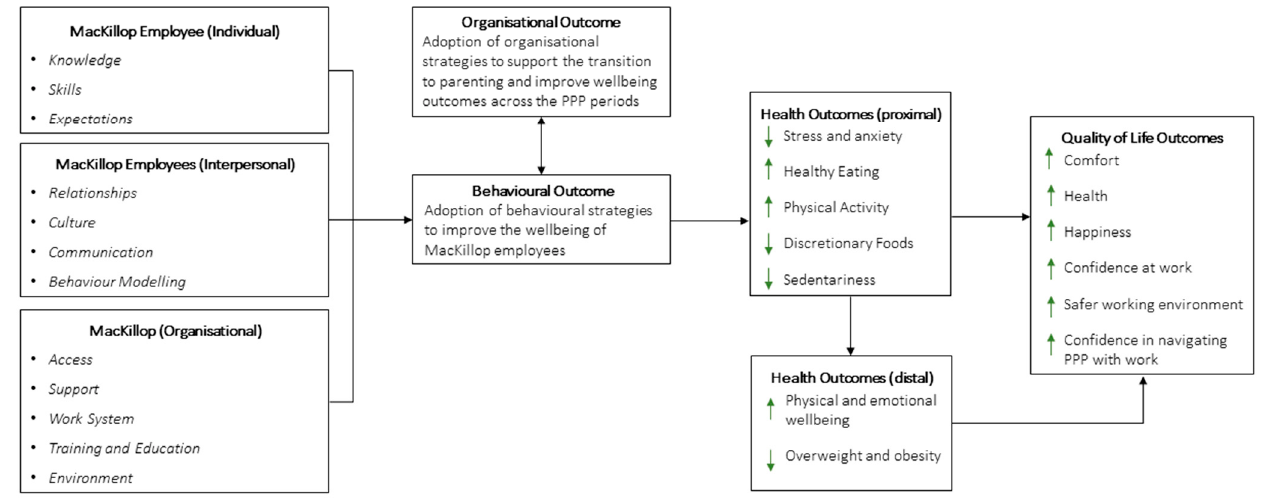
Figure 1. Logic Model of the HiPPP Portal.